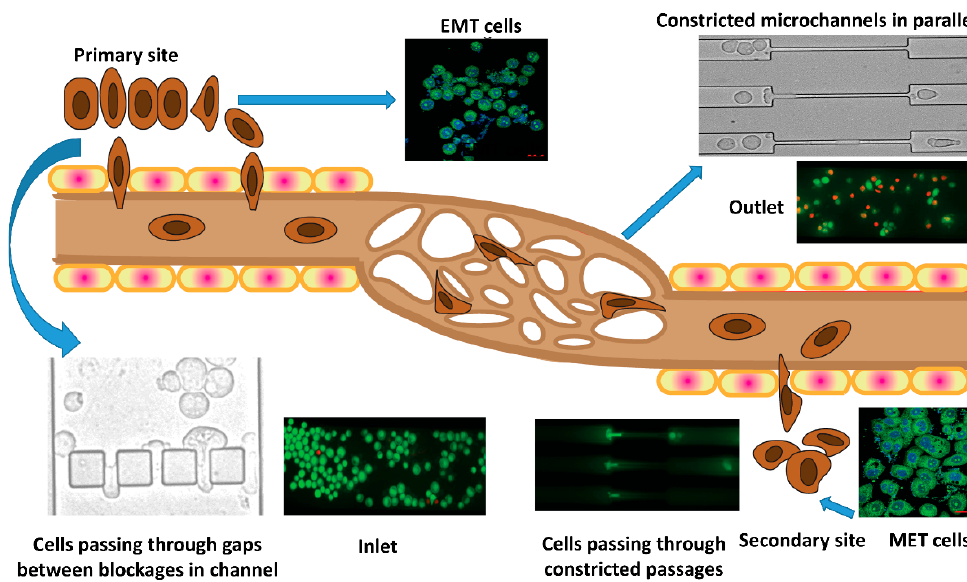
Figure 1. Schematic representation of the motion of metastatic cancer cells from the primary site to a distant secondary site through microcapillaries.